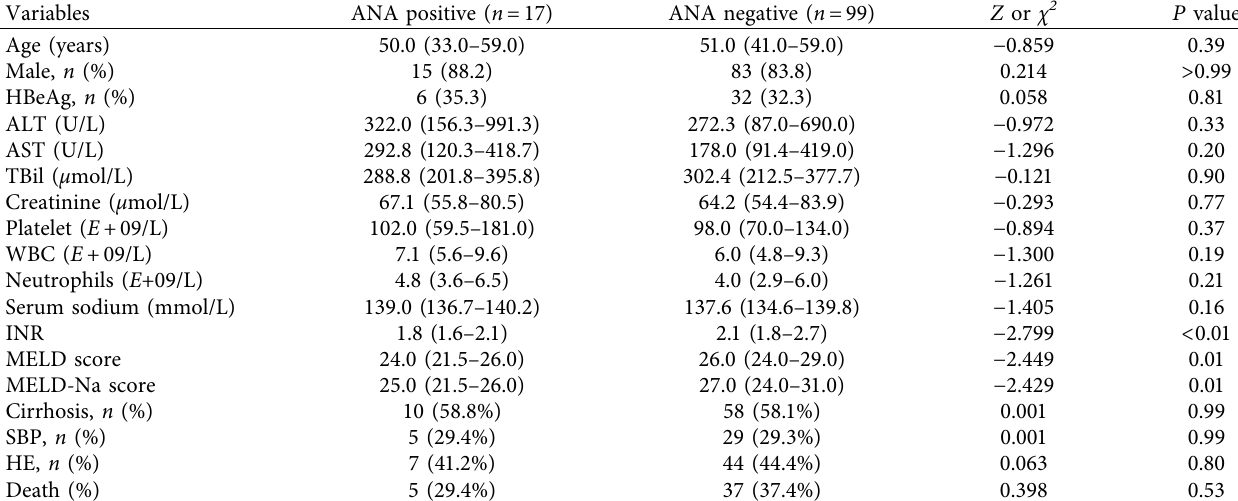
Table 1: Characteristics of patients with ACLF.